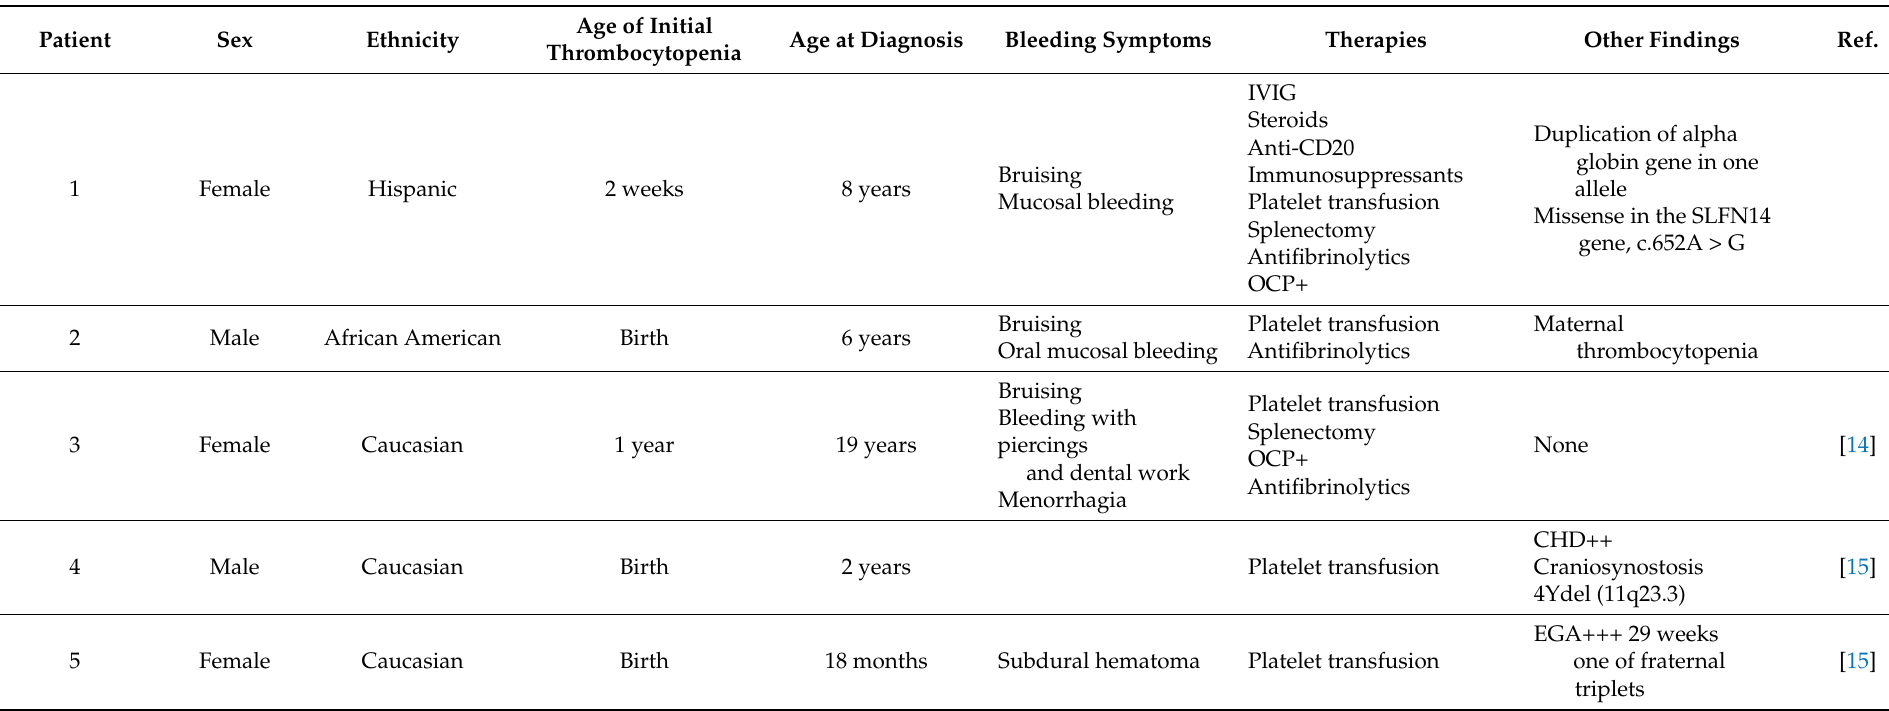
Table 1. Clinical Findings in Patients with Reported Medich Syndrome. + OCP; oral contraceptives; ++ CHD: congenital heart disease; +++ EGA; estimated gestational